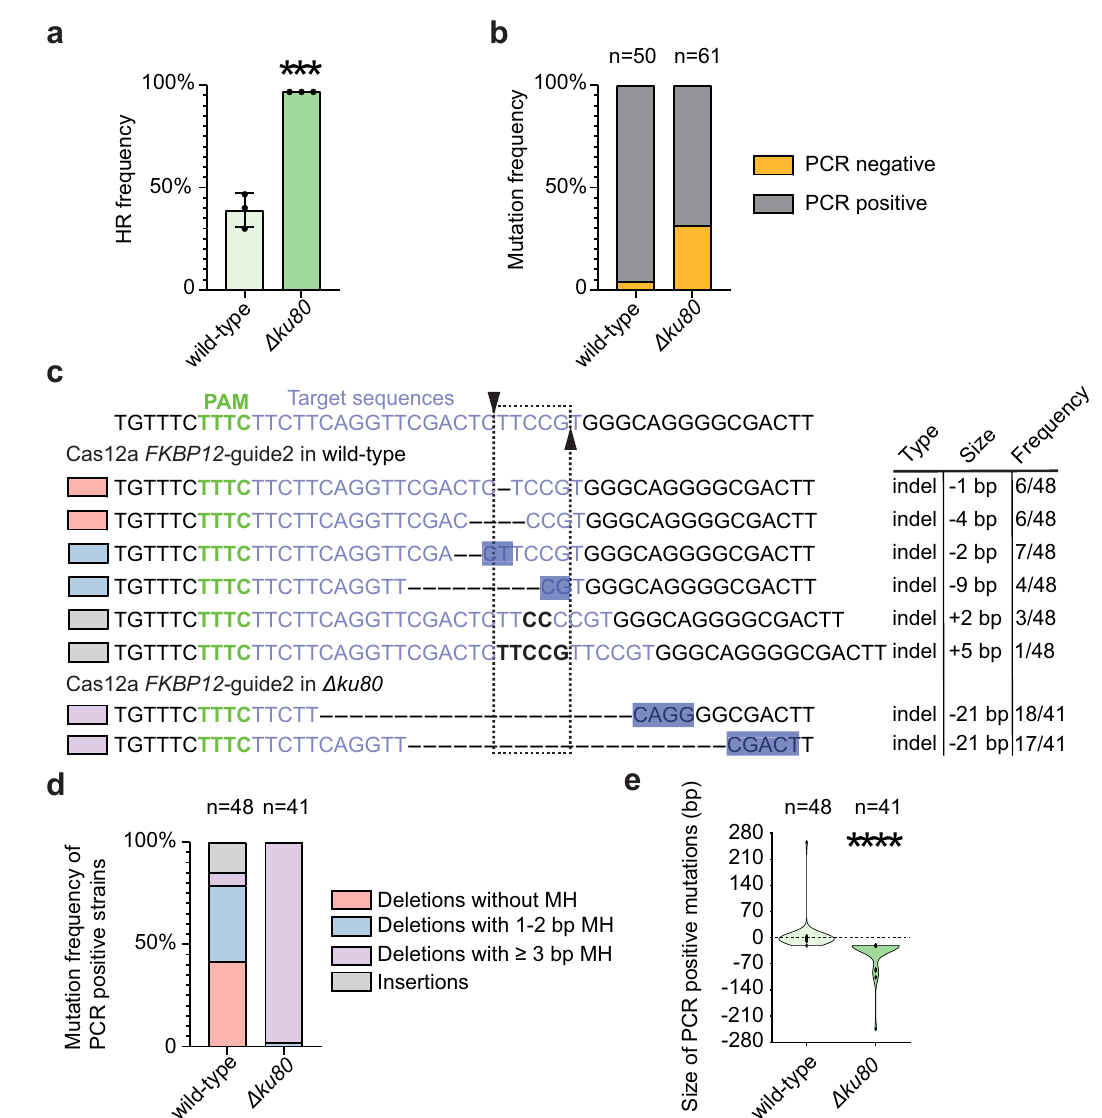
triangles indicate the nuclease site for Cas12a. Letters in blue boxes highlight microhomologyattherepairjunction.Thetype,sizeandfrequencyofeachediting outcome is listed in the right panel. d The mutation frequency of PCR positive Δ fkbp12 mutants.Thenumberofindependenttransformantsgenotyped(x)islisted ( n =x)collectedfromtwoindependenttransformationsforwild-typeandthreefor Δ ku80 . The frequencies show the average outcome across replicates. e Size of deletions and insertions from PCR positive Δ fkbp12 mutants. Deletions were con- siderednegativevalues,whileinsertionstreatedaspositivevalues.****Indicatesa p - value ≤ 0.0001 (Mann Whitney test, two-sided, p -value<0.0001). The number of independent transformants genotyped (x) is listed ( n =x) collected from two independent transformations for wild-type, and three independent transforma- tions for Δ ku80 . Source data are provided as a Source Data fi